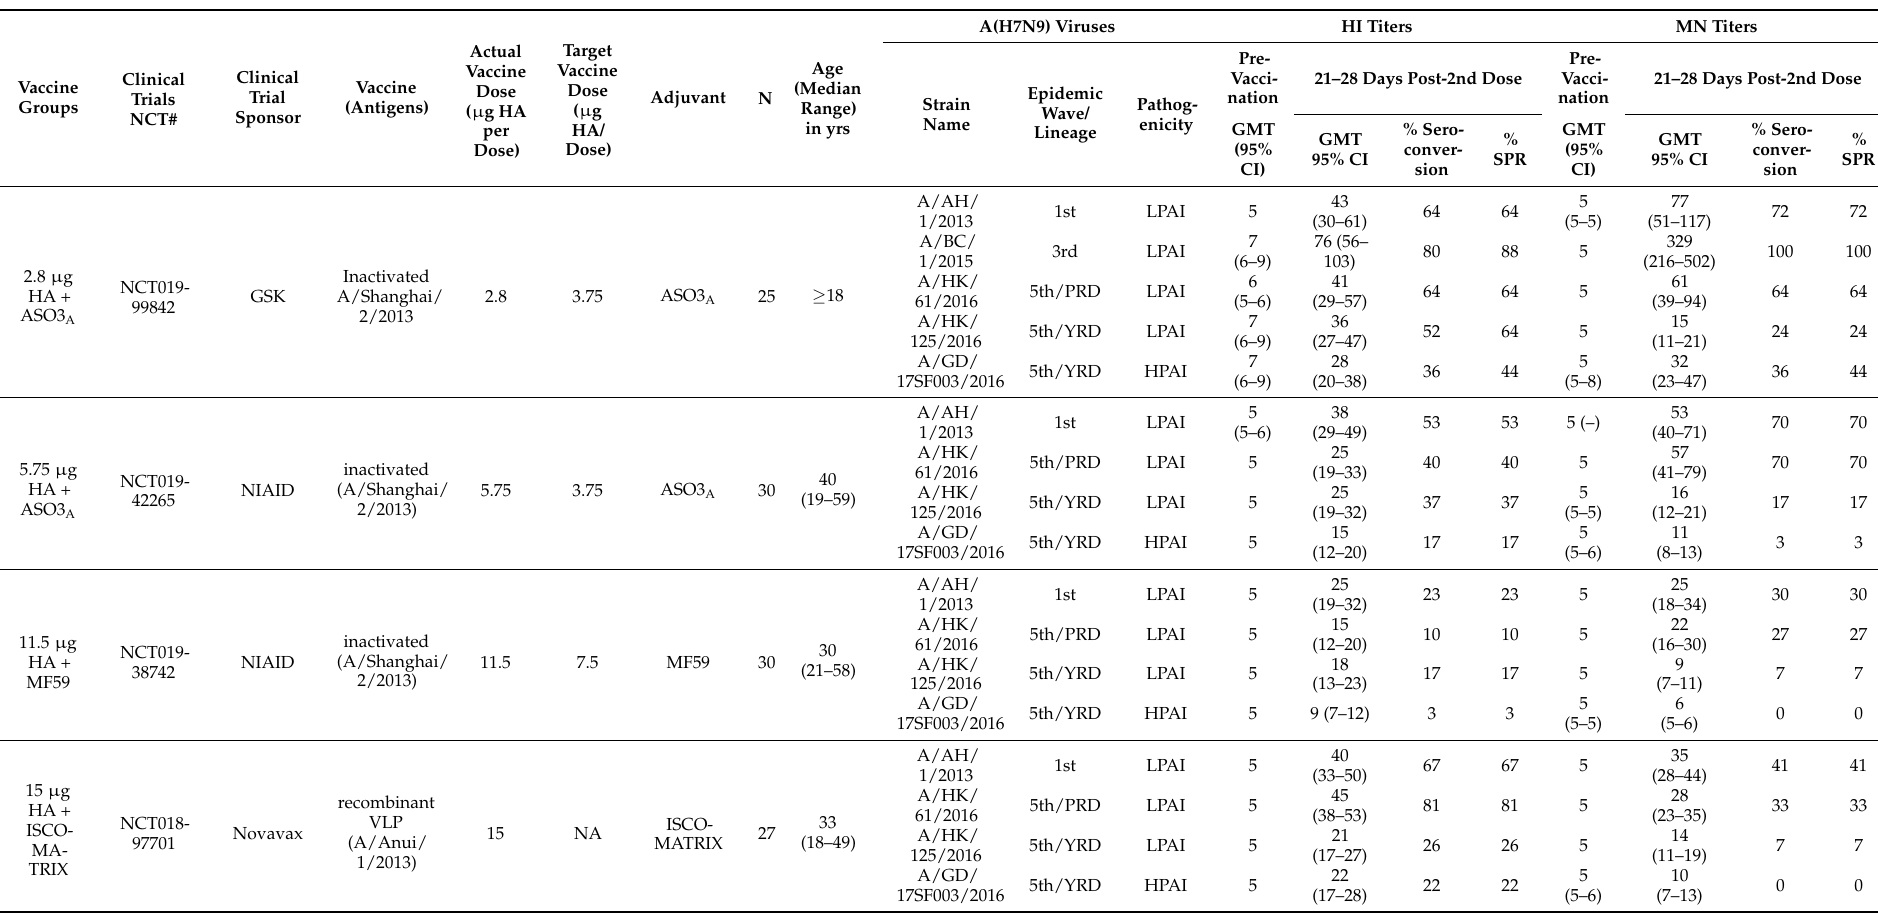
Table 1. Homologous and heterologous HI and MN antibody responses to the 1st, 3rd and 5th wave A(H7N9) viruses following vaccination with the 1st wave vaccines in 4 vaccine groups based on 3 vaccine technology platforms and 4 antigen/adjuvant